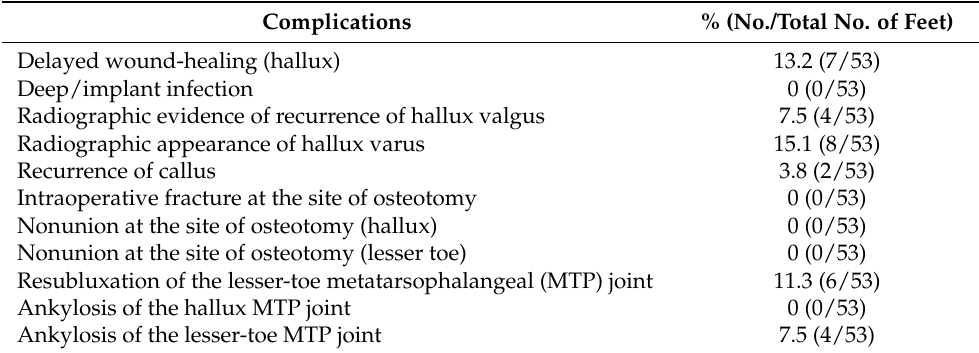
Table 5. Postoperative complications after